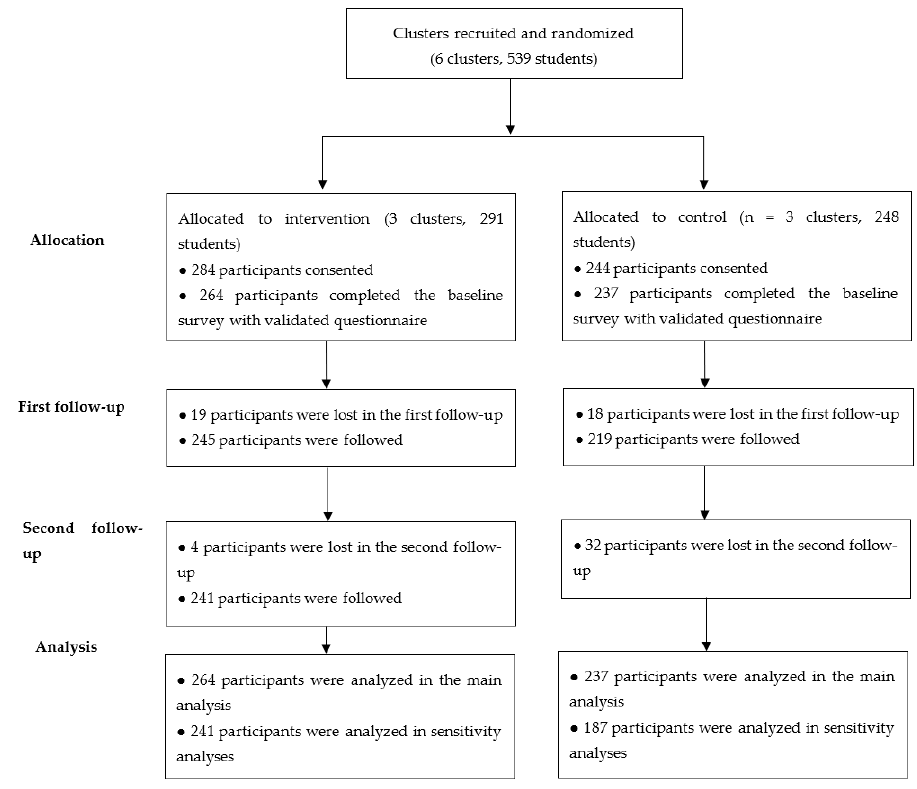
Figure 1. Trial flow diagram.